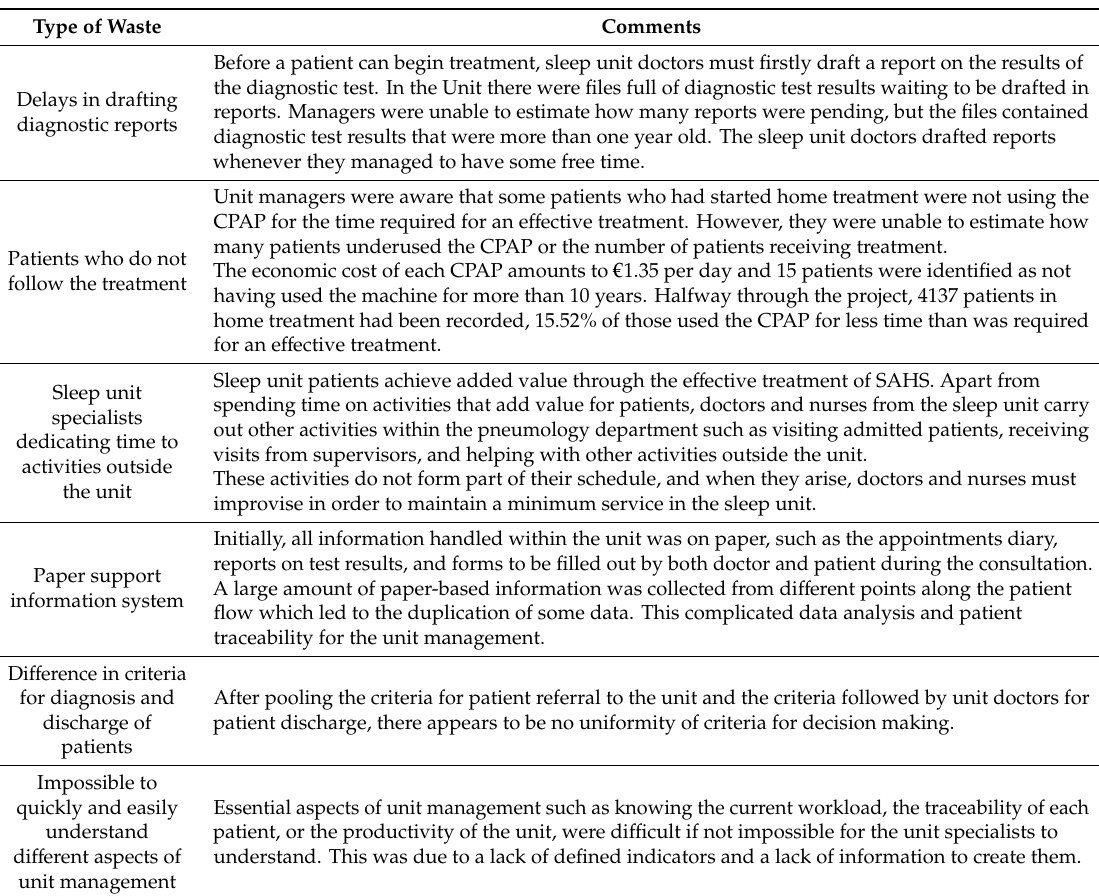
Table 2. Waste with indirect impact on the